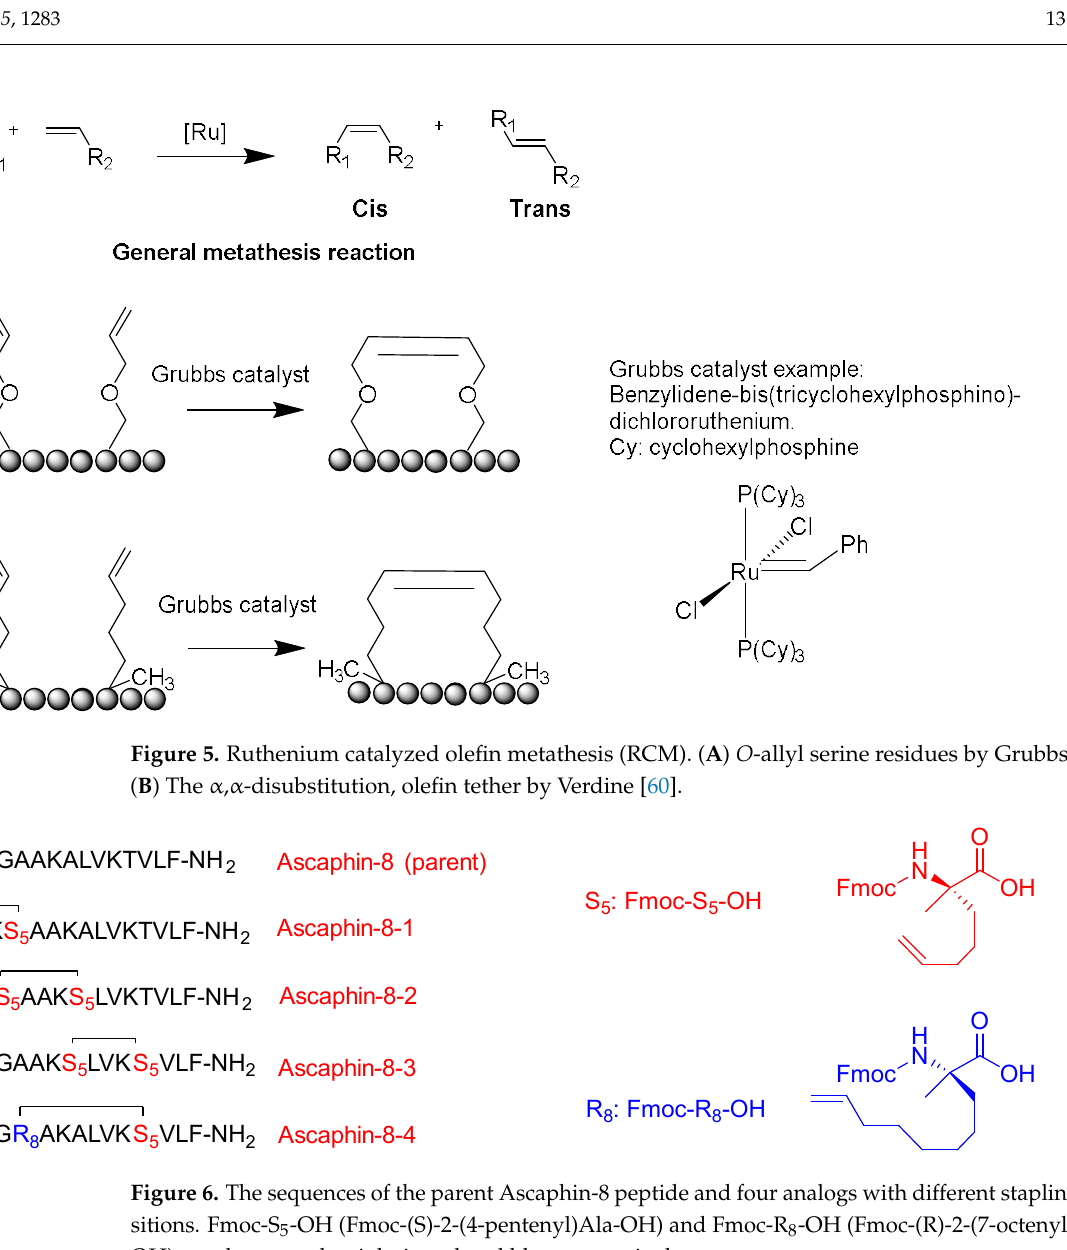
Figure 6. The sequences of the parent Ascaphin-8 peptide and four analogs with different stapling positions. Fmoc-S 5 -OH (Fmoc-(S)-2-(4-pentenyl)Ala-OH) and Fmoc-R 8 -OH (Fmoc-(R)-2-(7-oc- tenyl)Ala-OH) are shown at the right in red and blue, respectively.